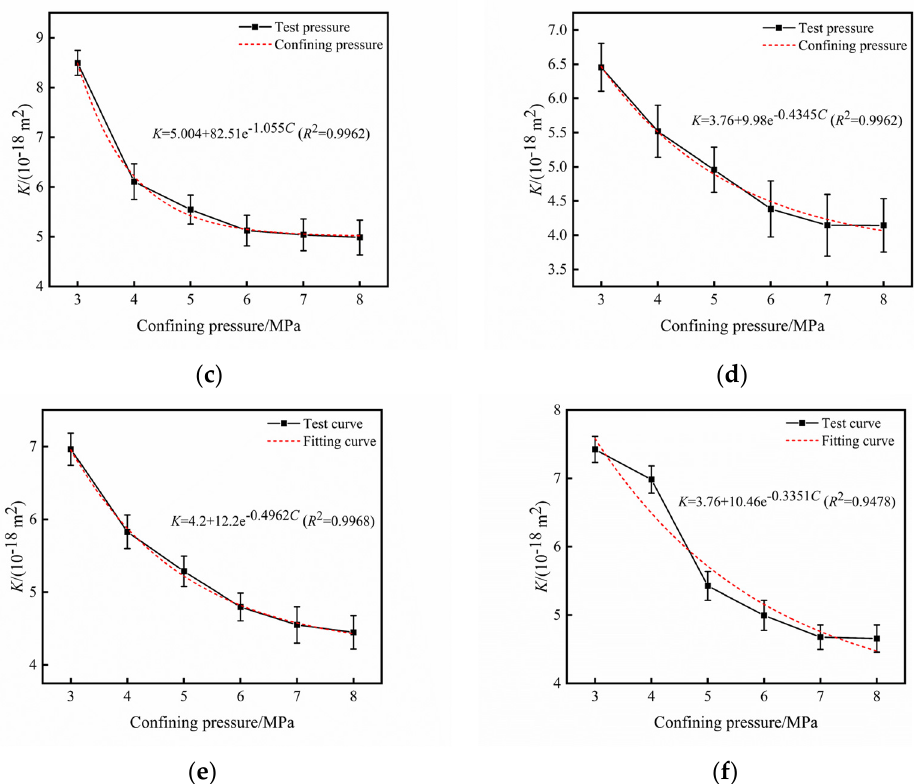
Figure 14. Permeability: ( a ) RC group; ( b ) BFC group; ( c ) PFC group; ( d ) BPRC 1 group; ( e ) BPRC 2 group; ( f ) BPRC 3 group.